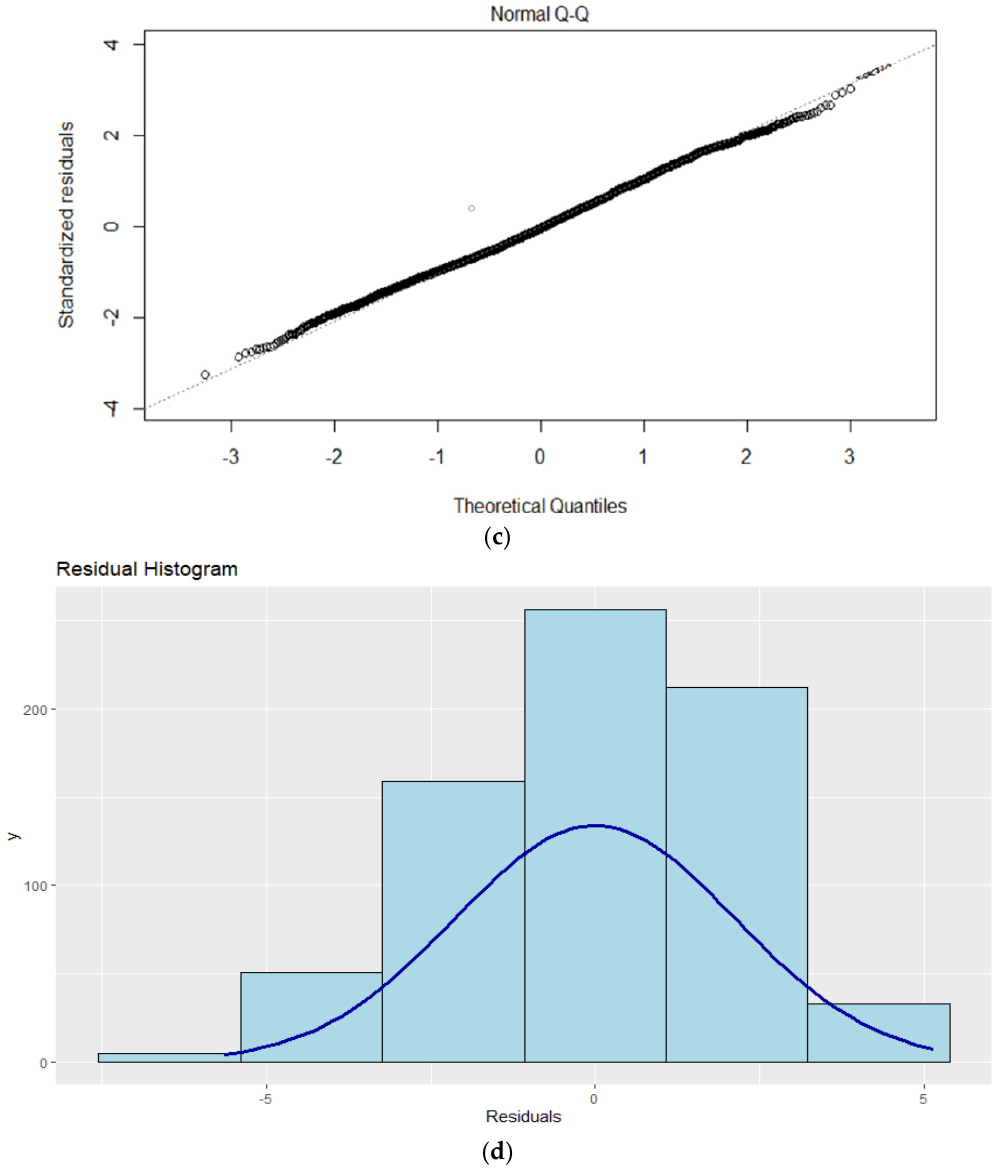
Figure 5. MLR residual diagnostics plots for ( a ): normal Q-Q plot, and ( b ) histogram of the residuals for boys ( c ): normal Q-Q plot, and ( d ) histogram of the residuals.